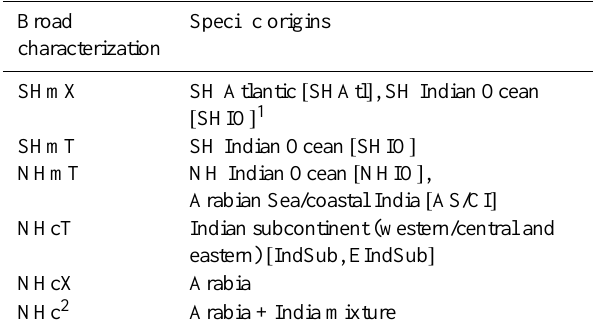
Table 7. Air mass origins encountered during the pre-INDOEX and INDOEX cruises, characterized by broad regions, along with the more specific characterizations of Quinn et al. (2002); the ab- breviations in square brackets refer to those used in Fig.